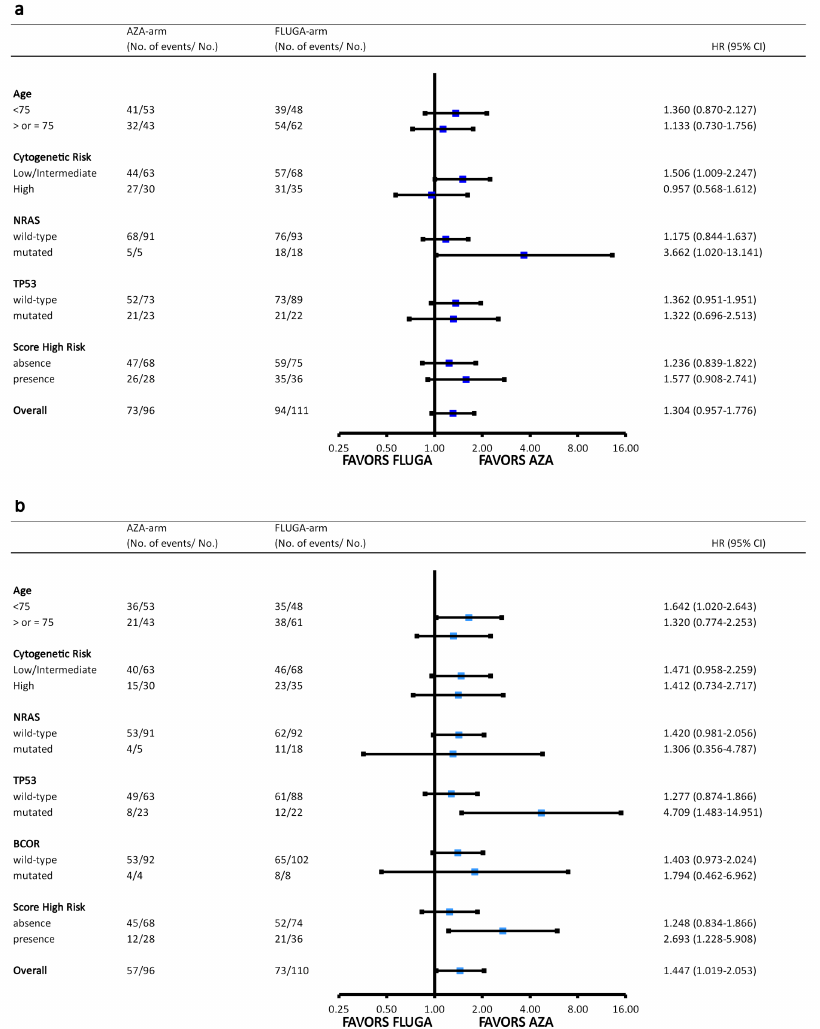
Figure 3. Subgroup analysis of overall survival and progression-free survival via biological and genomic characteristics. HR: hazard ratio, cytogenetic risk: low–intermediate vs. high risk as per ELN 2017 classification; a high-risk score was defined by the presence of mutated NRAS or TP53 . ( a ) in the subgroup analyses of overall survival via biological and genomic characteristics, we observed that patients with low–intermediate cytogenetic risk (hazard ratio (HR0 1.51, p = 0.045) and mutated NRAS (HR 3.66, p = 0.047) could benefit from azacytidine. ( b ) in the subgroup analyses of relapse-free survival, we observed that patients with mutated TP53 (HR 4.71, p = 0.009) and scores indicating a high risk for AML (HR 2.69, p = 0.013) showed a higher chance of relapse-free survival under the AZA